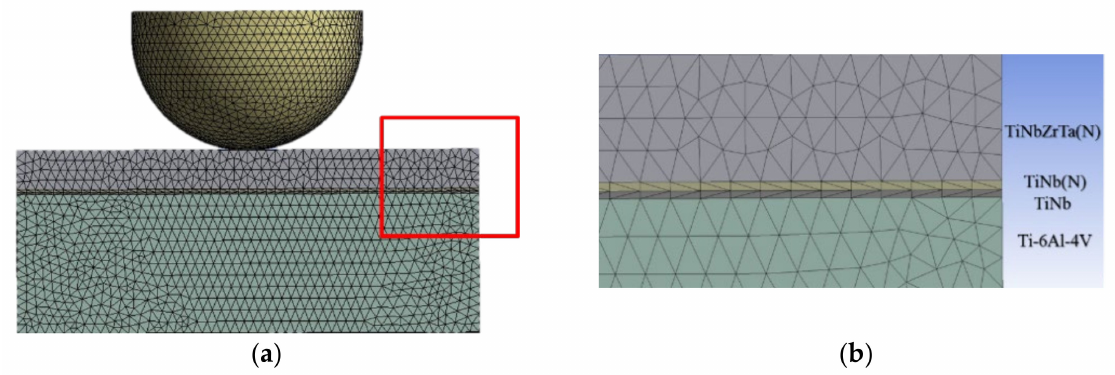
Figure 3. ( a ) Front view and ( b ) enlarged view of the TiNbZrTa(N) model with mesh size of 0.0004 mm.